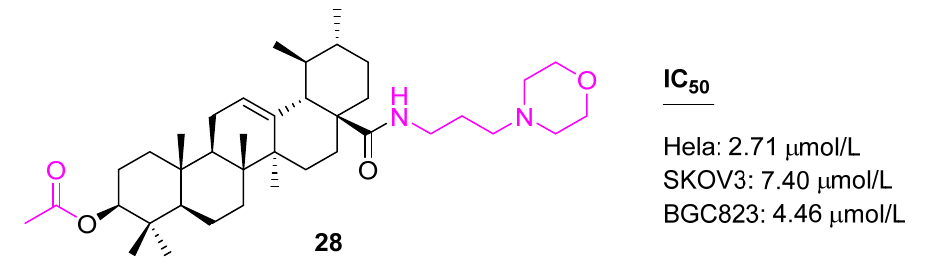
Figure 17. Structure of 27 .